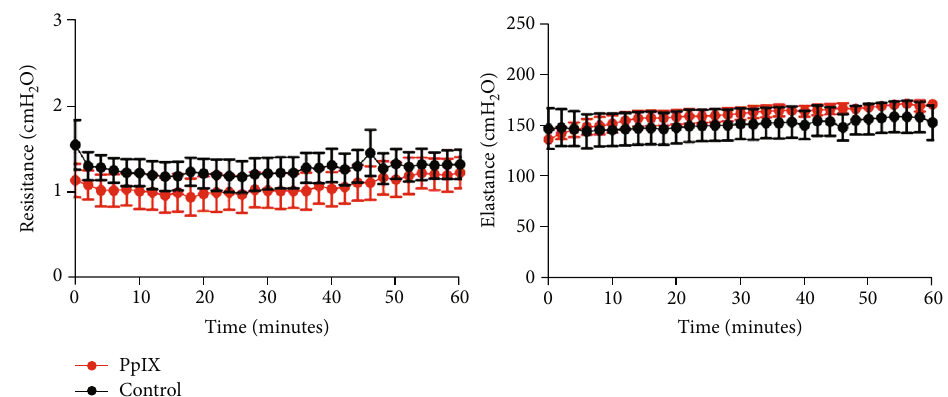
Figure 4: Values of pulmonary resistance and elastance of the control group and protoporphyrin IX group in relation to time during photodynamic therapy.